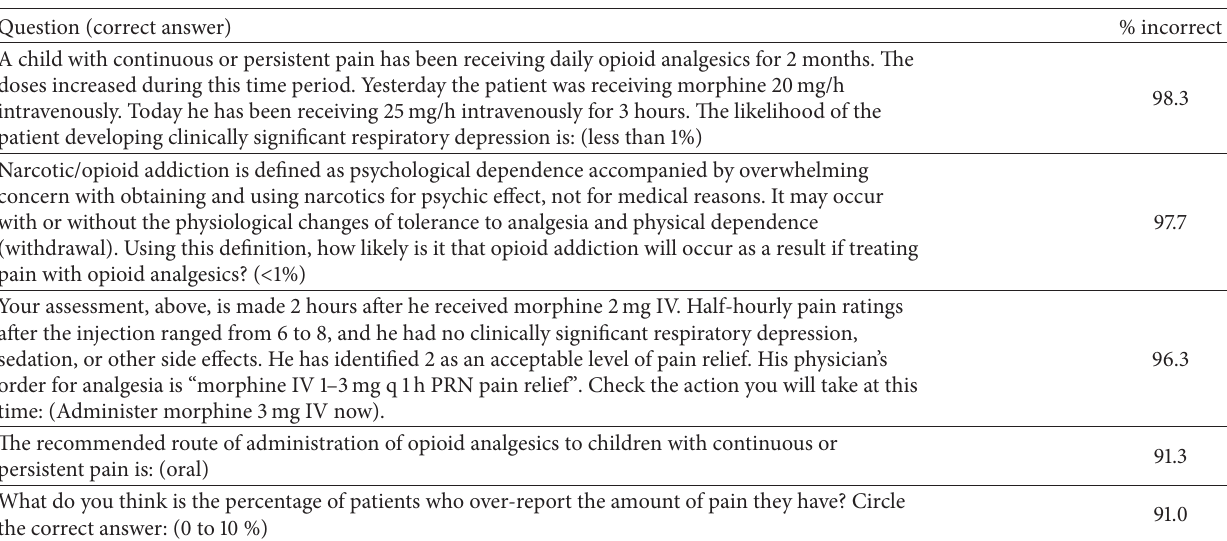
Table 7: Top 5 questions answered incorrectly by nursing students.